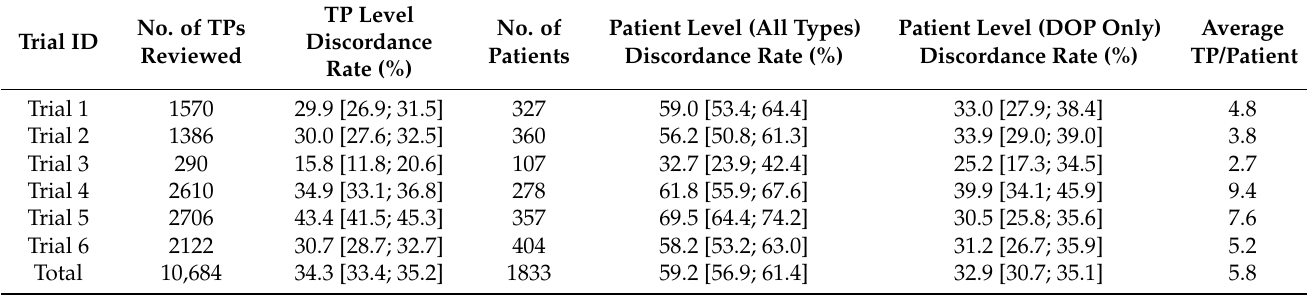
Table 2. Discordance rates per trial.